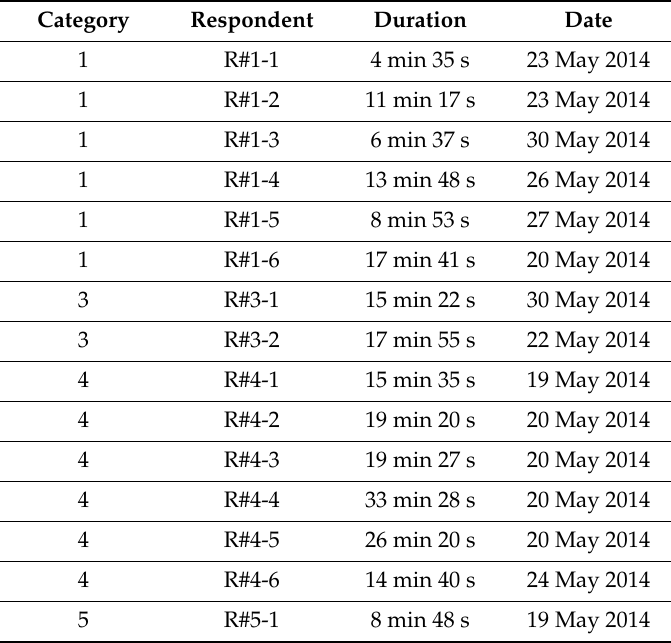
Table 3. Overview of the follow-up